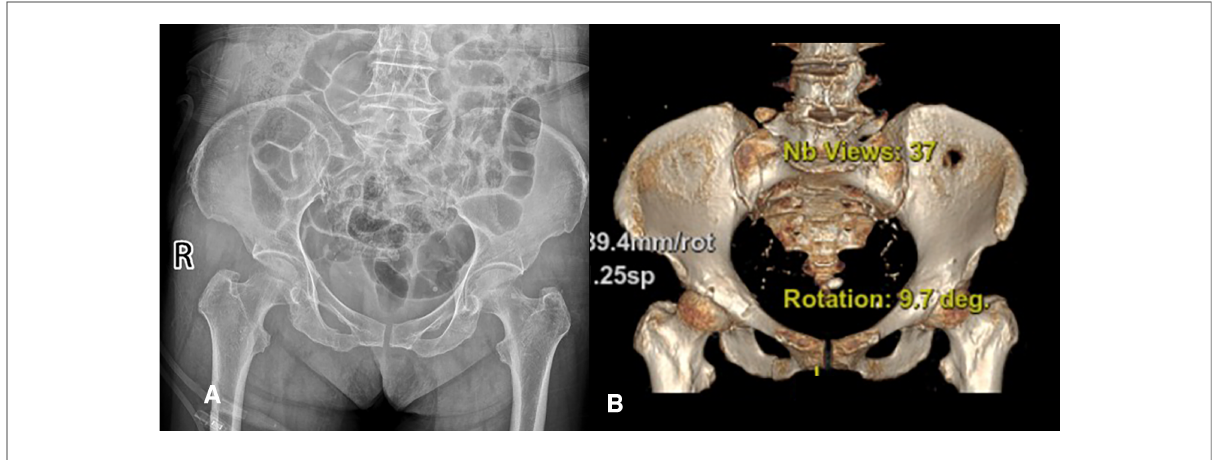
FIGURE 1 The imaging examination before surgery. ( A ) The anteroposterior radiograph of pelvis. ( B ) Three-dimensional reconstruction of pelvis.